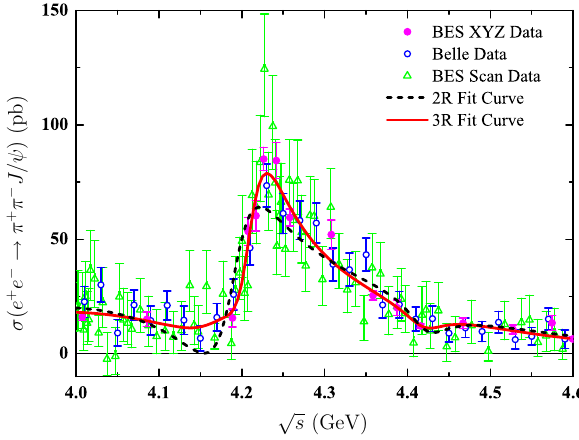
to place the observed Y states in the charmonium family.